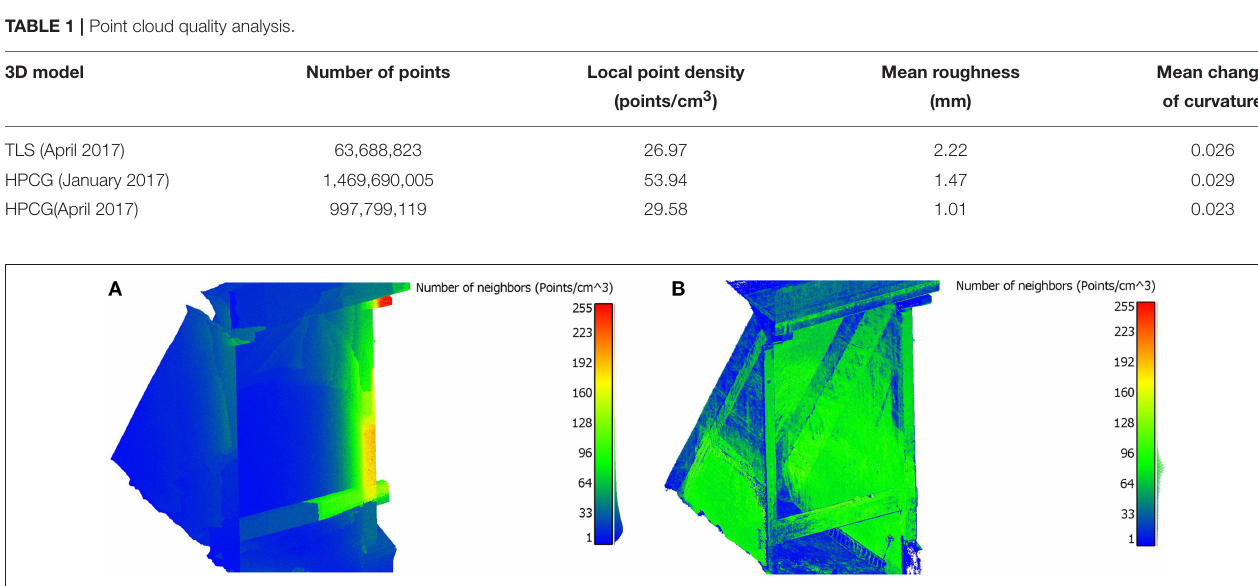
FIGURE 9 | Local point density for Bay#5; low to high density ranges from dark to light intensity: (A) Day One dataset; (B) Day Two dataset.